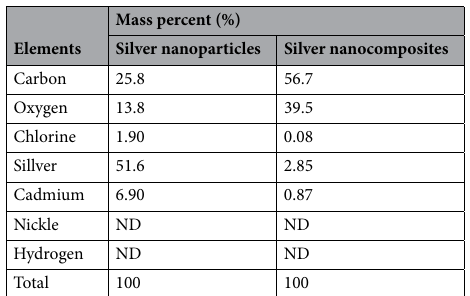
Table 1. Quantitative elemental analysis of silver nanoparticles and silver nanocomposites. ND not